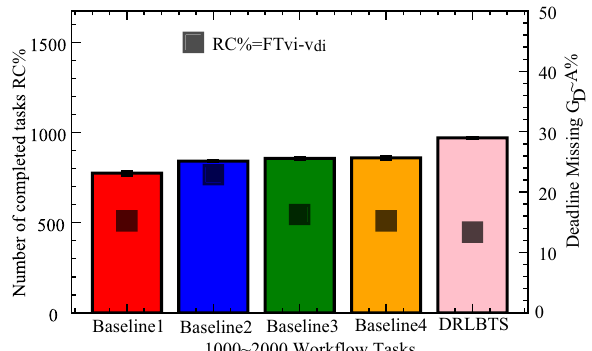
Figure 8. Baseline deep and reinforcement learning schemes for